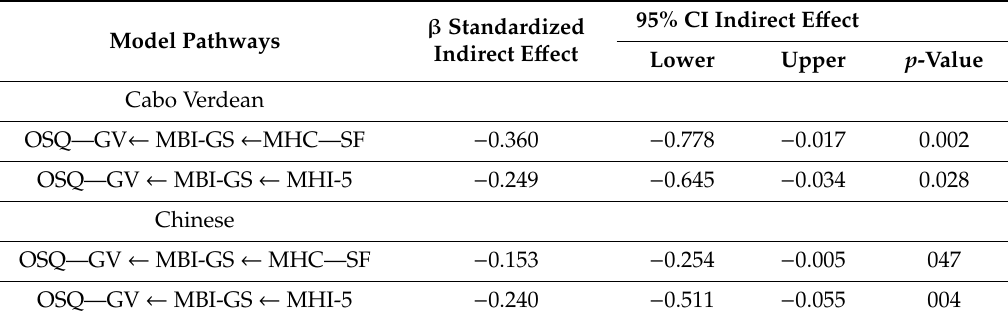
Table 3. Bootstrap results for the indirect e ff